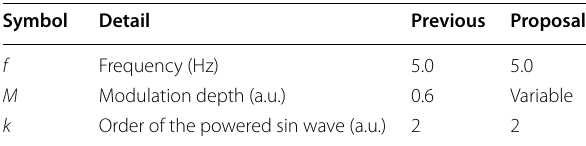
Table 3 Parameter values of the previous and the pro- posed methods Symbol